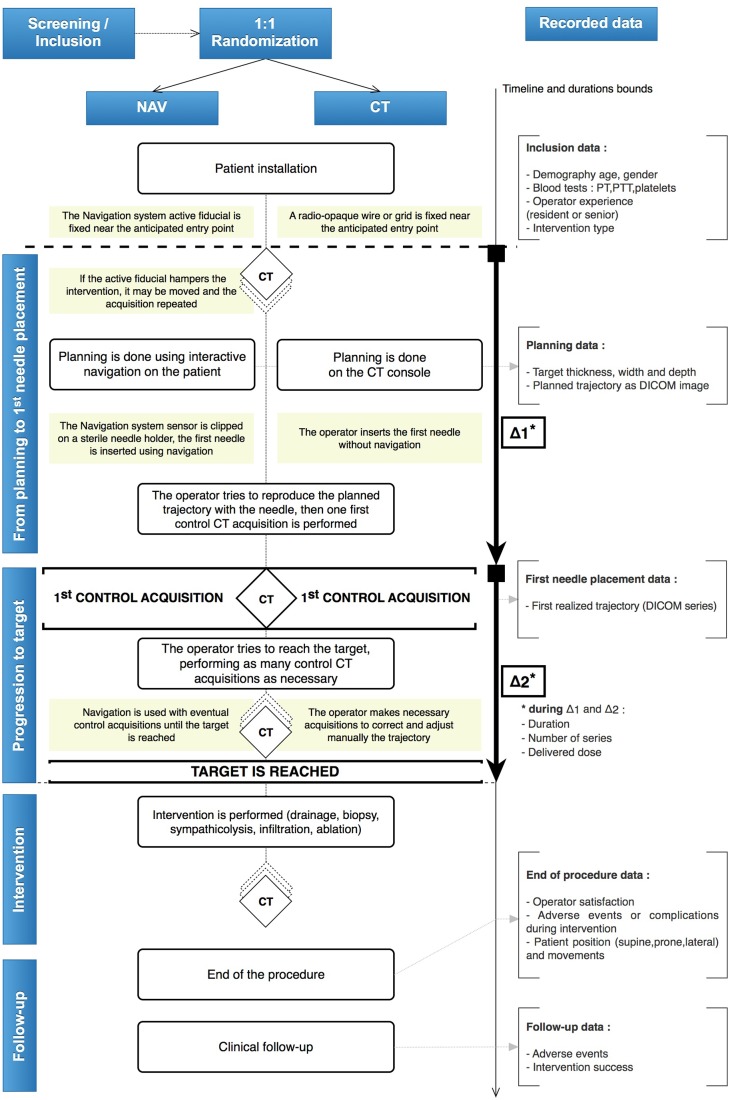
CTNAV trial protocol.The operator tries to reproduce as accurately as possible the planned trajectory using a navigated procedure (NAV group) or the standard procedure (CT group). The main outcome is the difference in distance and angle between the achieved and the planned trajectories.